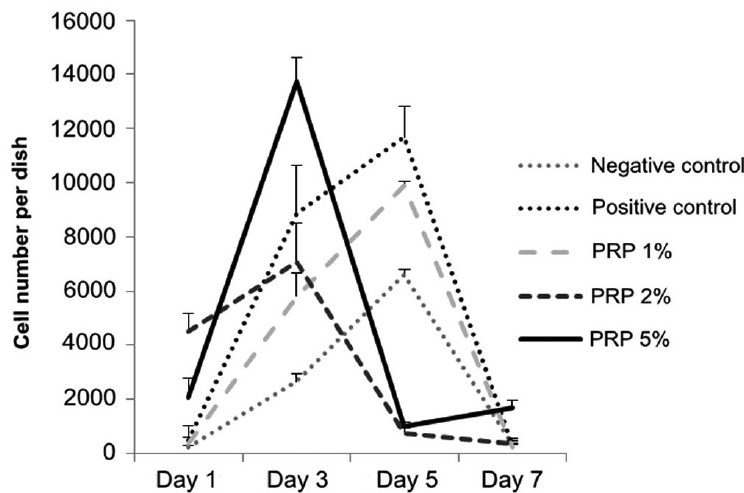
Figure 1- Cell number cultivated in experimental media at days 1, 3, 5 and 7 (Haemocytometer cell counting